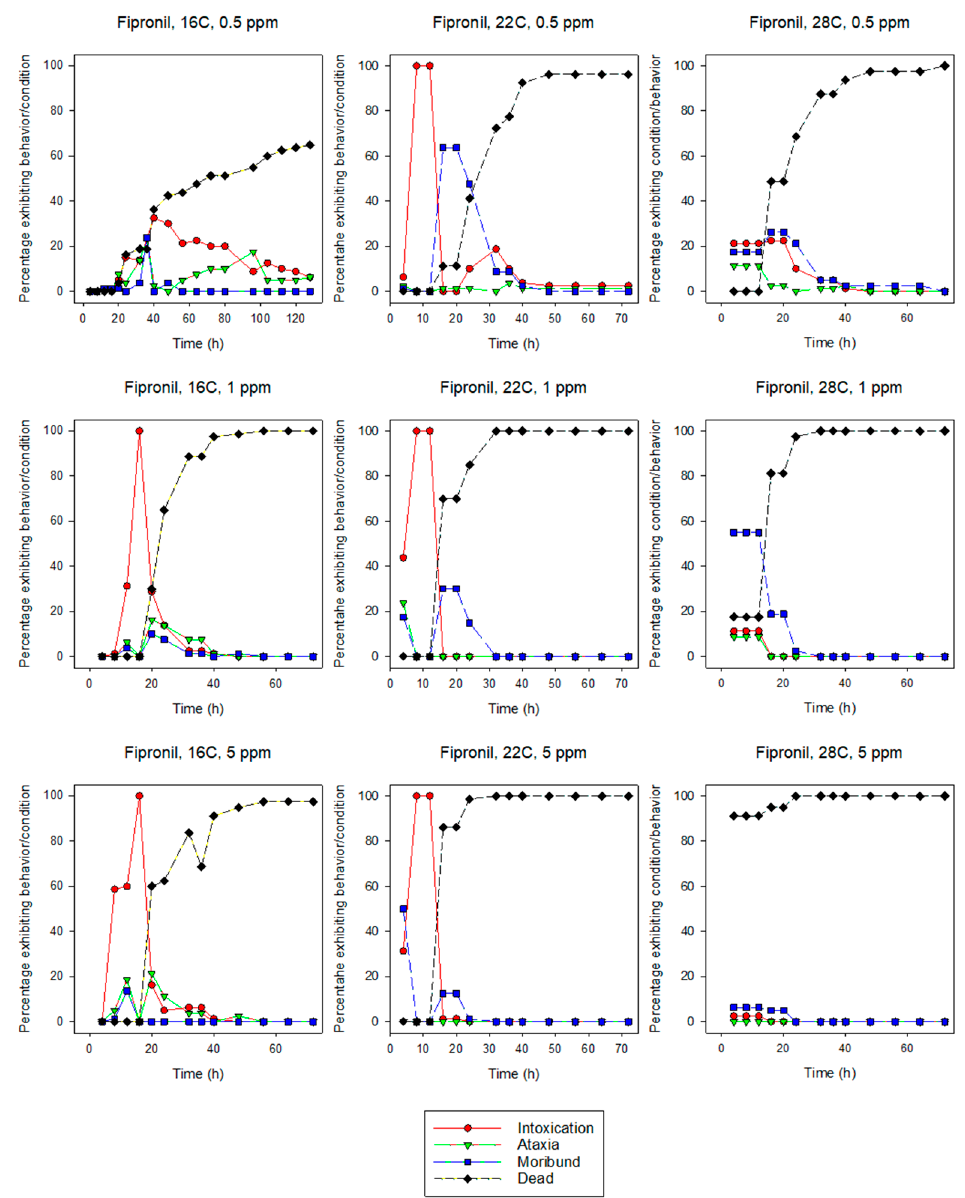
Figure 1. Effects of concentration and temperature on the behaviors of fipronil-exposed eastern subterranean termites, R. flavipes .